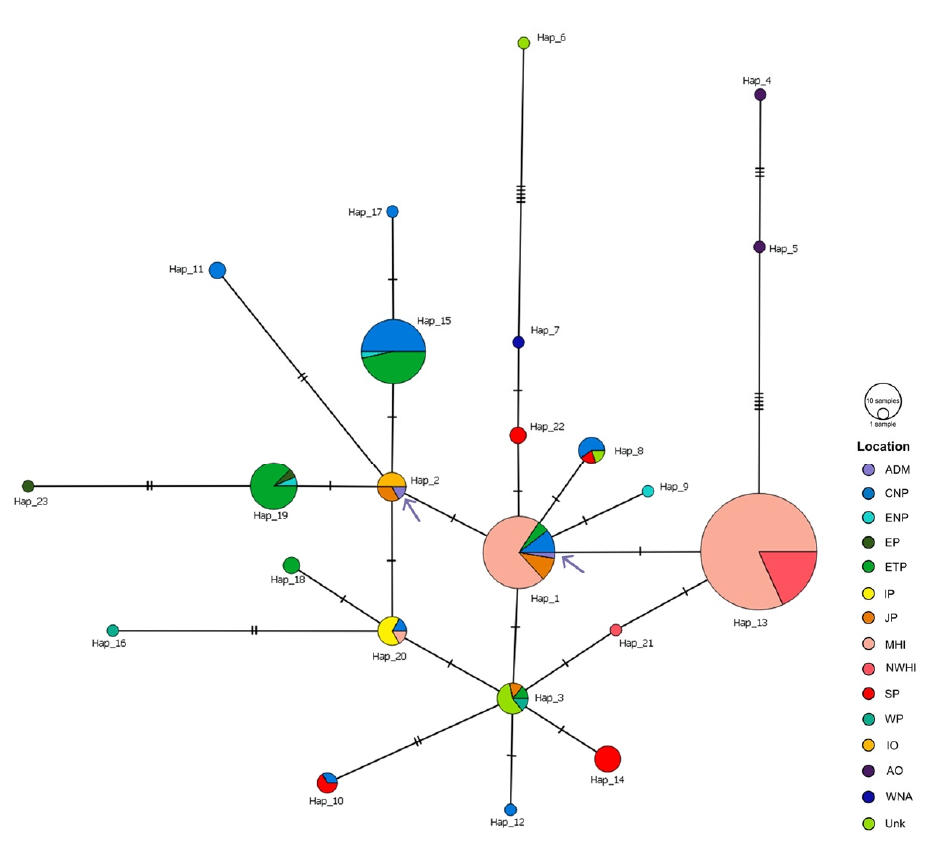
Figure 4. Median joining network (MJN) of all false killer whale mtDNA control region haplotypes. The MJN was generated from 323 base pairs of false killer whale mtDNA control region sequences and indicated that 23 haplotypes were found in 15 locations. Each haplotype is colored by location. The size of each circle is proportional to its haplotype frequency, while nucleotide substitutions are shown at the branches as small transverse bars. Purple arrows indicate haplotypes from the Thai Andaman Sea. Abbreviations of location are as follows: ADM, Thai Andaman Sea; CNP, Central